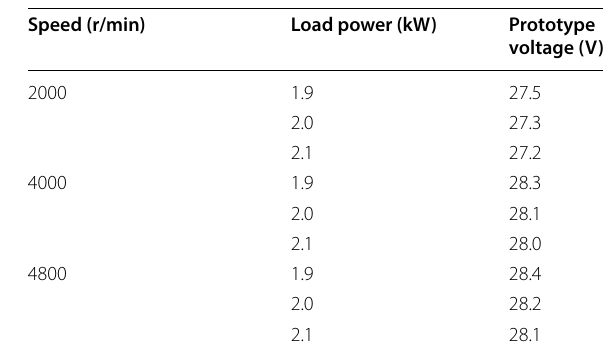
Table 2 Results of the generator output